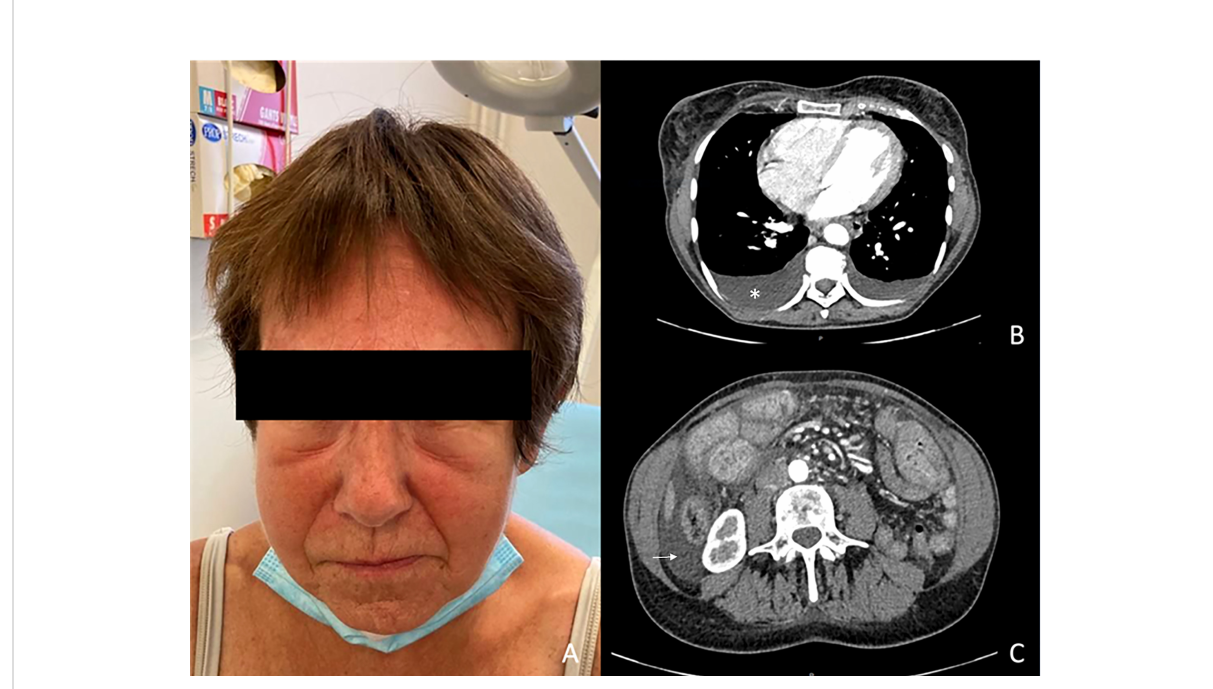
FIGURE 1 Clinical photography (A) and CT-scan images (B, C) . (A) Facial edema (B) Pleural effusion (white star). (C) Ascites (white